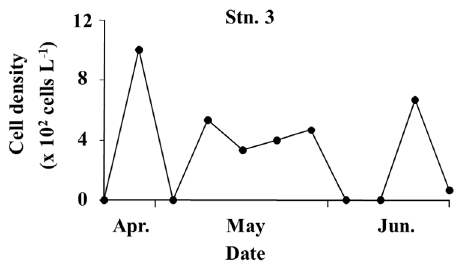
Figure 4. Temporal changes in the abundance of cells of the toxic dinoflagellate Alexandrium catenella (Group I) in the surface seawater at Stn. 3. No cells of A. catenella were detected at Stns. 1 and 2.